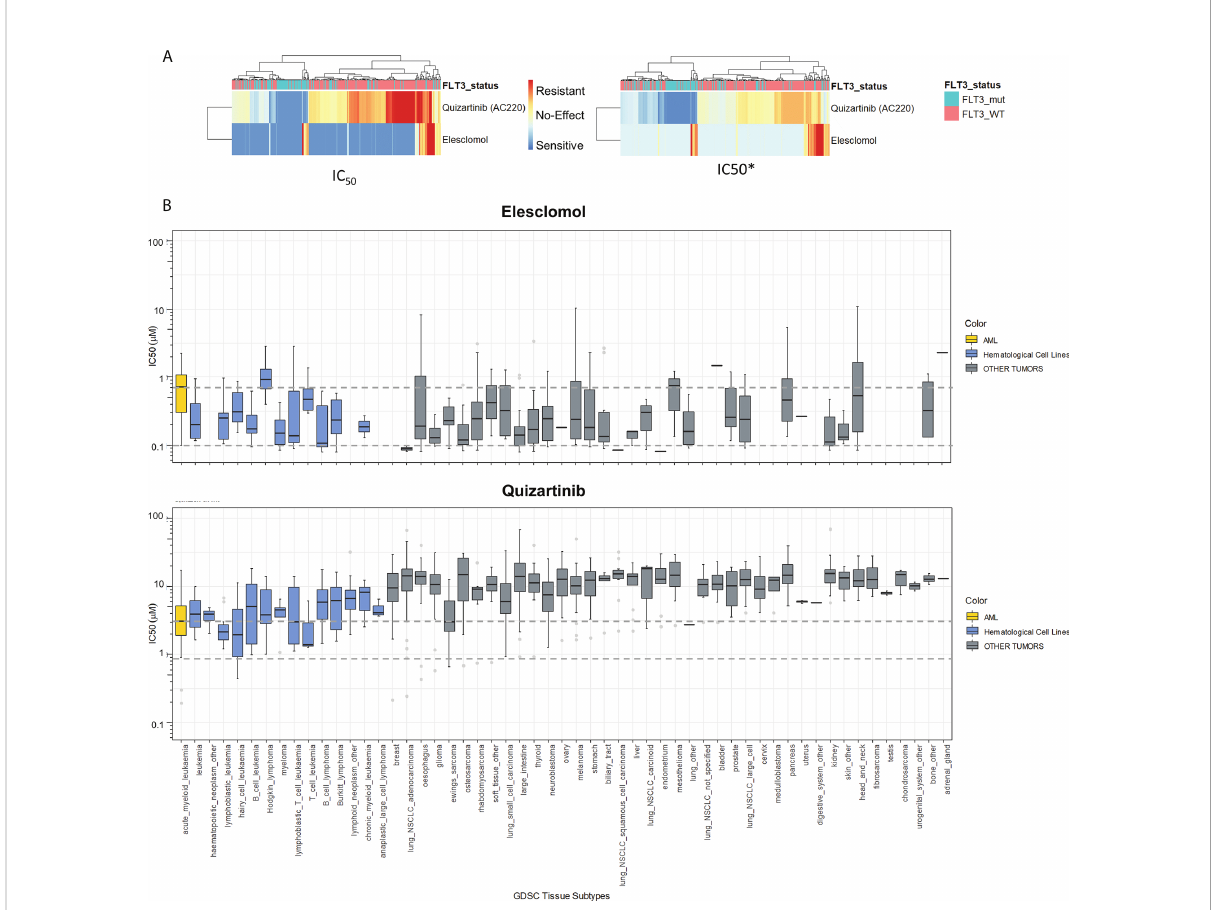
FIGURE 3 IC 50 Normalization to Avoid Drug Toxicity. (A) Drug Sensitivity Heatmap in BeatAML cohort. The left panel shows the IC 50 values for AML tumors of BeatAML. Effectiveness of a drug in a patient is plotted in blue color, and resistance is represented in red color. The right panel shows the sensitivity in IC50* score. (B) Drug sensitivity of Quizartinib and Elesclomol across different tissue types using GDSC. IC 50 values relative to different tissues are shown in the graph. In yellow color are plotted the sensitivity values of AML cell lines, in blue color are plotted the drug sensitivity values for the Hematological cell lines, and fi nally in grey color, are plotted the sensitivity values for the non-hematological tissues from GDSC. Dotted grey lines represent the second IC 50 quantile for AML cell lines (GDSC: Genomics of Drug Sensitivity in Cancer). IC50* is the name of our new sensitivity